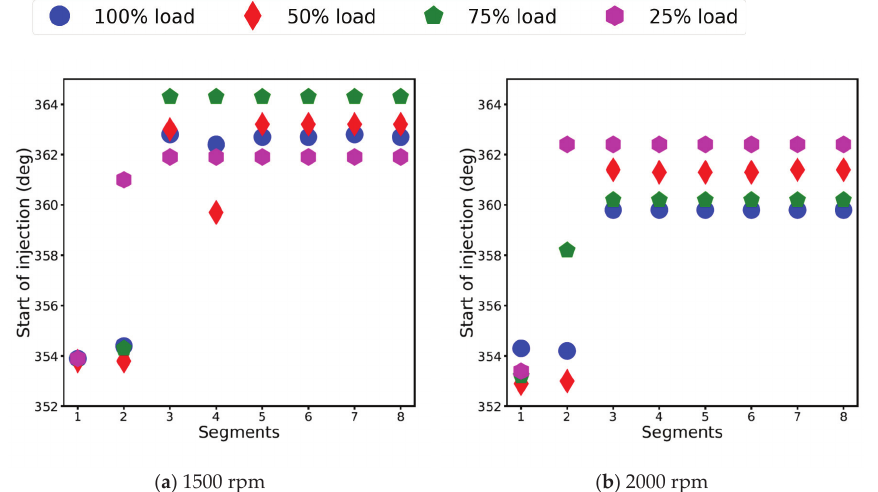
Figure 11. Brake specific fuel consumption (BSFC) at each load in each segment at ( a ) 1500 and ( b ) 2000 rpm. The blue circle represents 100% load, the red diamond 50% load, the green pentagon 75% load and the pink hexagon 25% load.